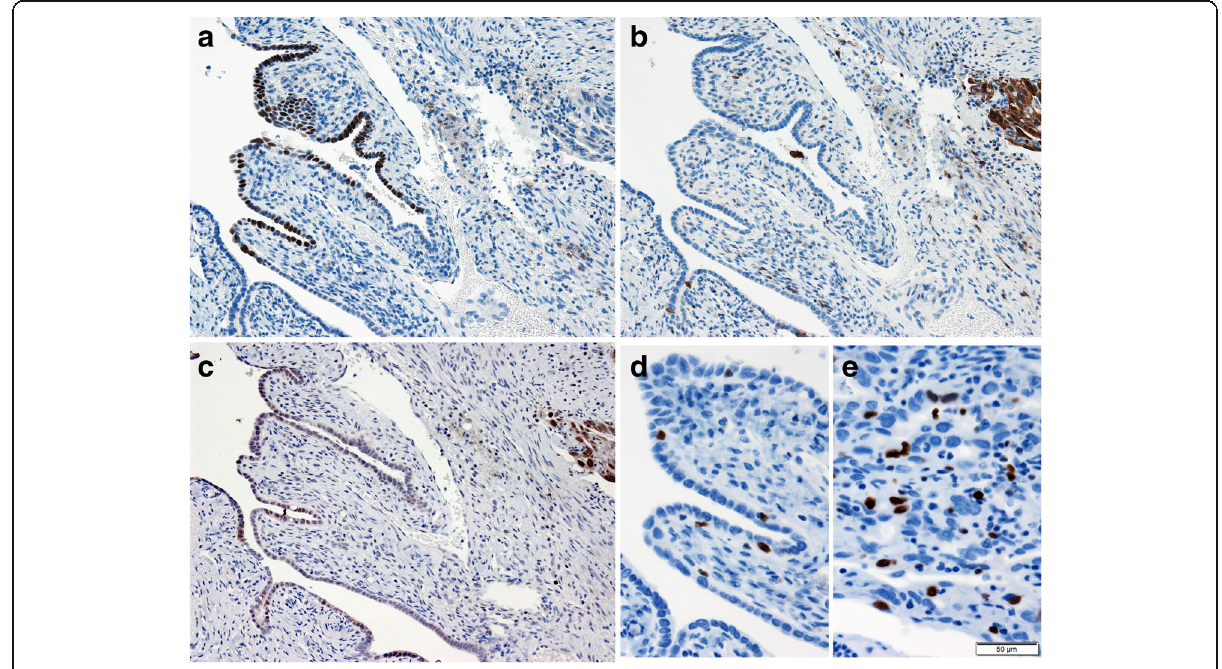
Fig. 2 γ -H2AX expression in the distal fallopian tube. ( a )-( c ) Representative immunostained images of the p53 ( a ), p16 ( b ) and γ -H2AX ( c ) protein expressions in the high-grade serous carcinoma (right) and p53 signature (left). ( d )( e ) Representative Ki-67 immunostained images of p53 signature ( d ) and high-grade serous carcinoma ( e